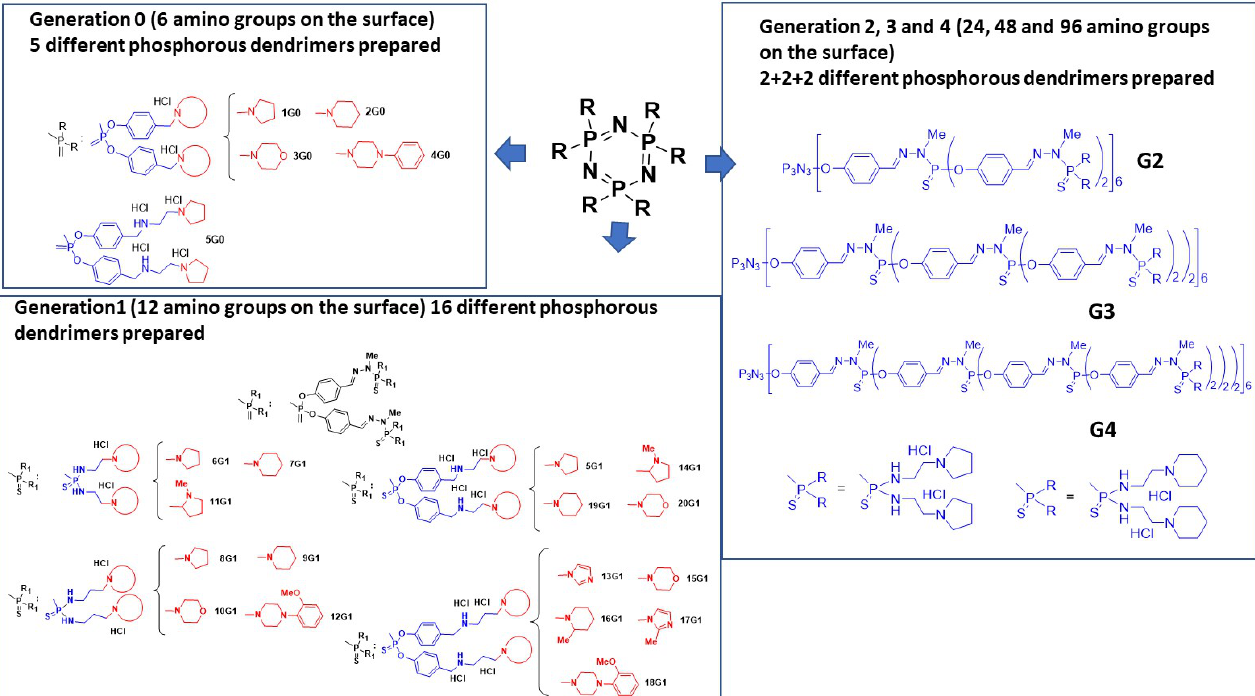
Figure 9. Chemical structures of prepared polycationic phosphorus dendrimers.